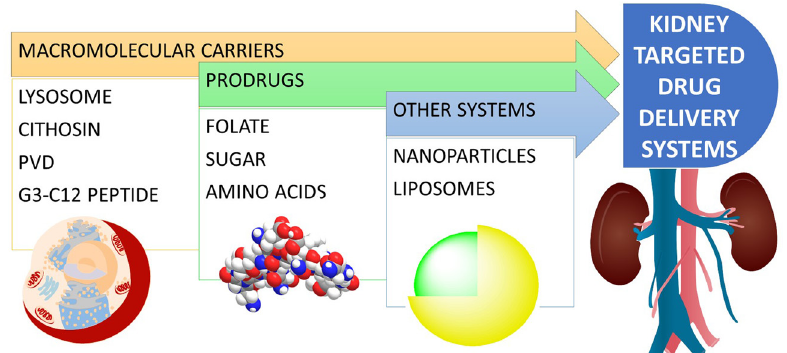
Figure 9: Kidney - targeted drug delivery